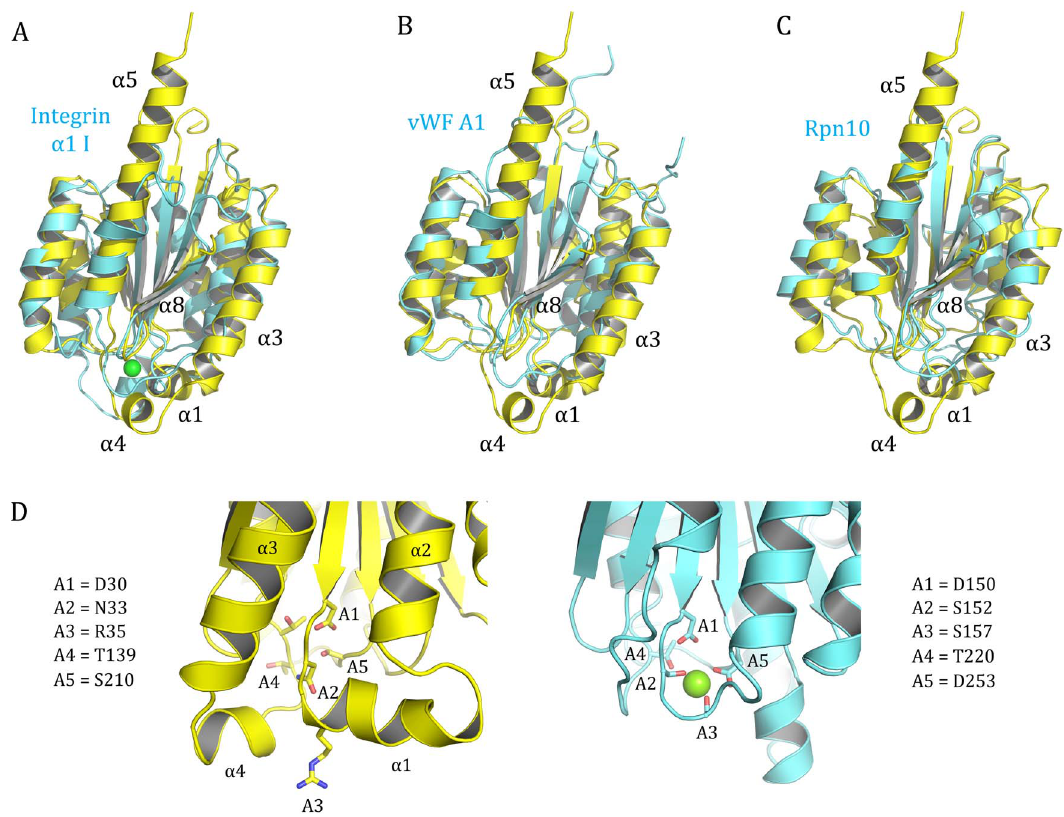
Figure 3. Structural similarity of p34ct compared to other vWA domains. Superposition of the p34ct 1-277 structure (yellow) with (A) the human Integrin a 1 I domain (pdb entry 1PT6), (B) the human vWF A1 domain (pdb entry 1AUQ) and (C) Rpn10 from Schizosaccharomyces pombe (pdb entry 2 6 5N, each in cyan). The putative metal coordination site in p34ct is enlarged (D) and compared to the MIDAS motif in human Integrin a 1 (cyan), with the 5 MIDAS elements (A1 – A5) shown in stick representation and the bound Mg 2 + ion in Integrin a 1 (1PT6) depicted as a green sphere. Residues corresponding to A1 – A5 are depicted next to the structural models.